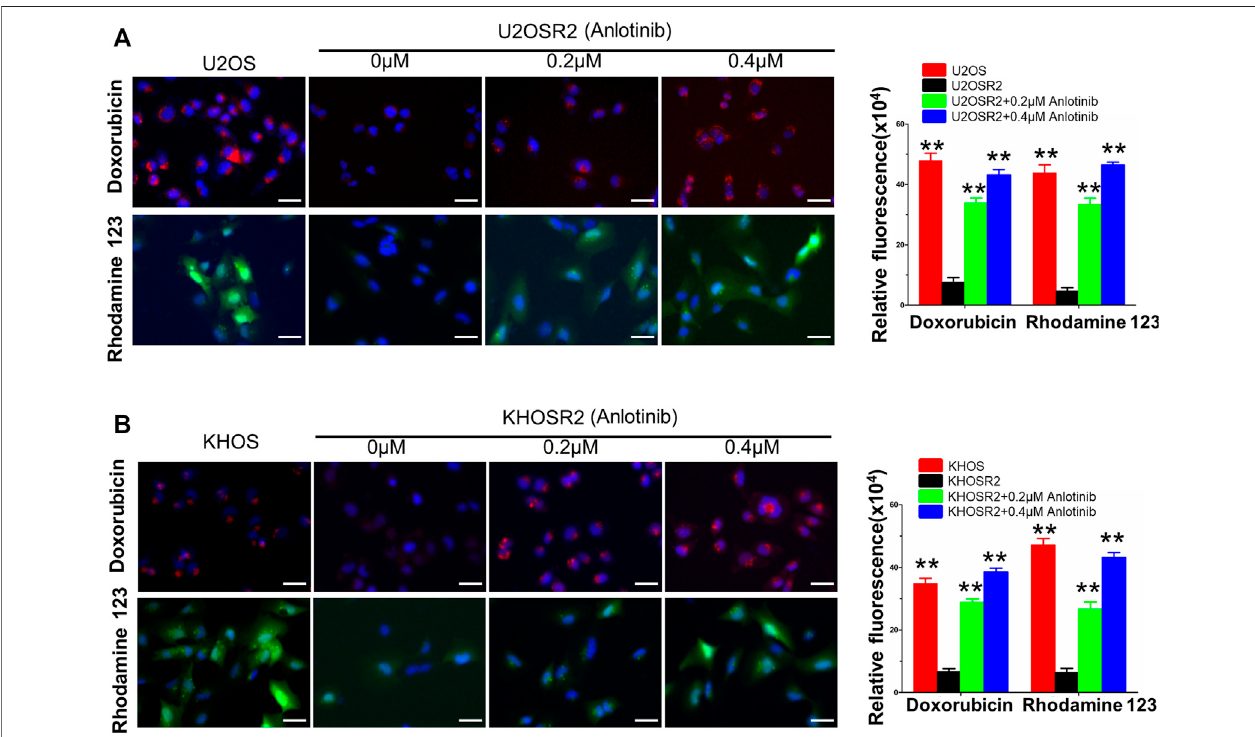
FIGURE 4 | Anlotinib increases the intracellular accumulation of DOX and Rho-123 in multidrug-resistant osteosarcoma cells. To visualize the effects of anlotinib onthe intracellular retention ofDOX and Rho-123, multidrug-resistant osteosarcomacells and their respectivedrug-sensitiveparentalcells wereseeded in six-well plates and exposed to Rho-123 and DOX with/without anlotinib pretreatment. The cells were fi xed and stained with DAPI. Fluorescence images were acquired by using a DMI3000B fl uorescence microscope. (A) . Anlotinib increases the intracellular accumulation of DOX and Rho-123 in U2OSR2 and U2OS cells. (B) . Anlotinib increases the intracellular accumulation of DOX and Rho-123 in KHOSR2 and KHOS cells. Scale bars (cid:1) 50 μ m. The fl uorescence integrated density was quanti fi ed and is represented by the lower lane bar graph. Data represent the mean ± SD of at least three independent experiments (* p < 0.05; ** p <